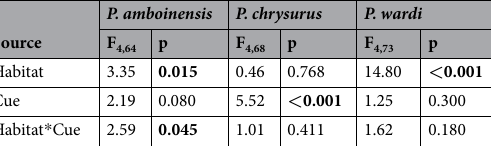
Table 1. Comparison of the fast-start response kinematics of three juvenile damselfishes that have been kept to seawater that has passed over live-healthy coral or dead-degraded coral (Habitat), and then either exposed to either clean seawater or conspecific alarm odours (Cues) within the burst arena just prior to being startled. Damselfish belong to the genus Pomacentrus . Results shown are the results of MANOVA’s on four kinematic variables (see text). The test statistic is Pillai’s